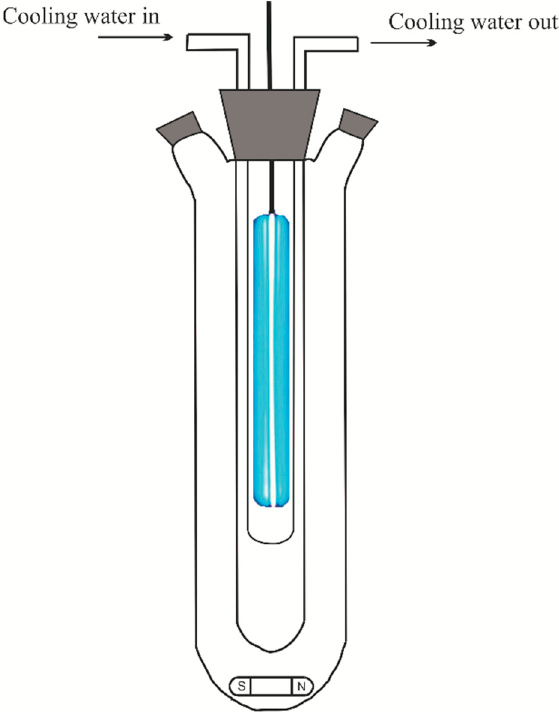
Figure 7. The experimental setup.